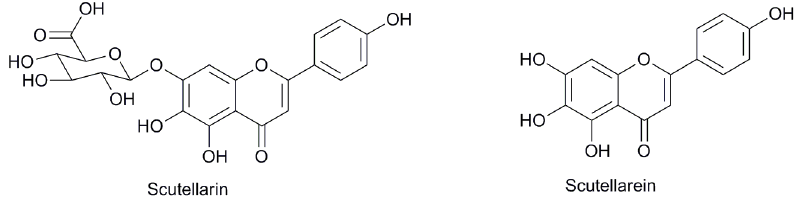
Fig 1. The chemical structures of scutellarin and